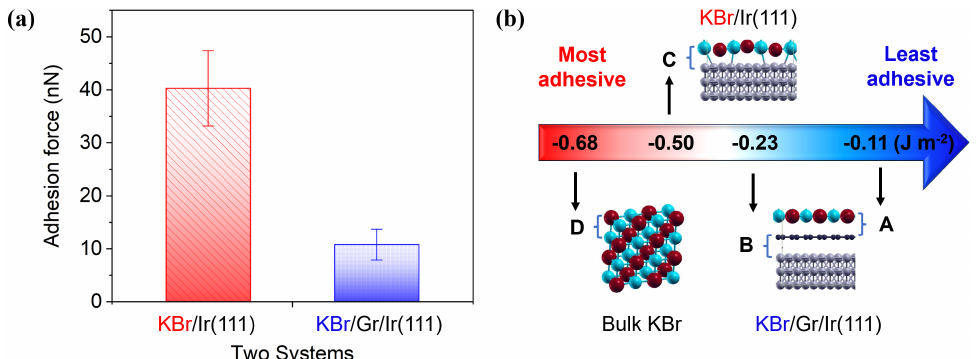
Figure 4. Adhesion force and energy of KBr on Ir(111) and Gr/Ir(111) evaluated by: ( a ) force spectroscopy in FFM and ( b ) DFT